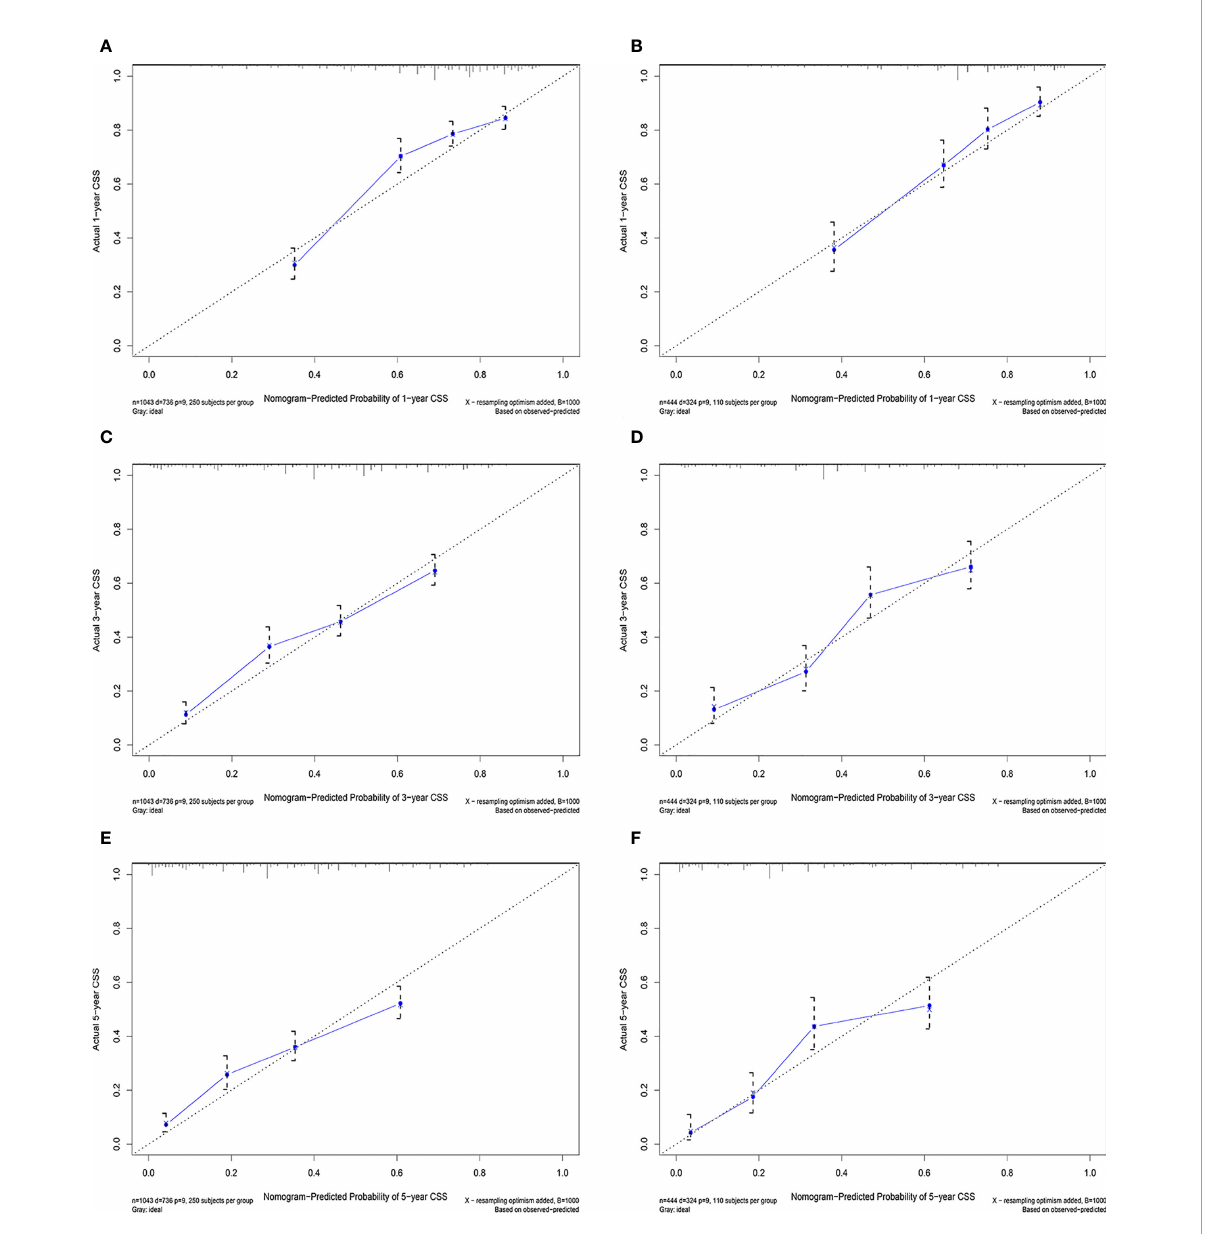
FIGURE 5 Calibration curves in the training (A, C, E) and validation (B, C, F) cohorts for 1-year, 3-year, and 5-year cancer-speci fi c